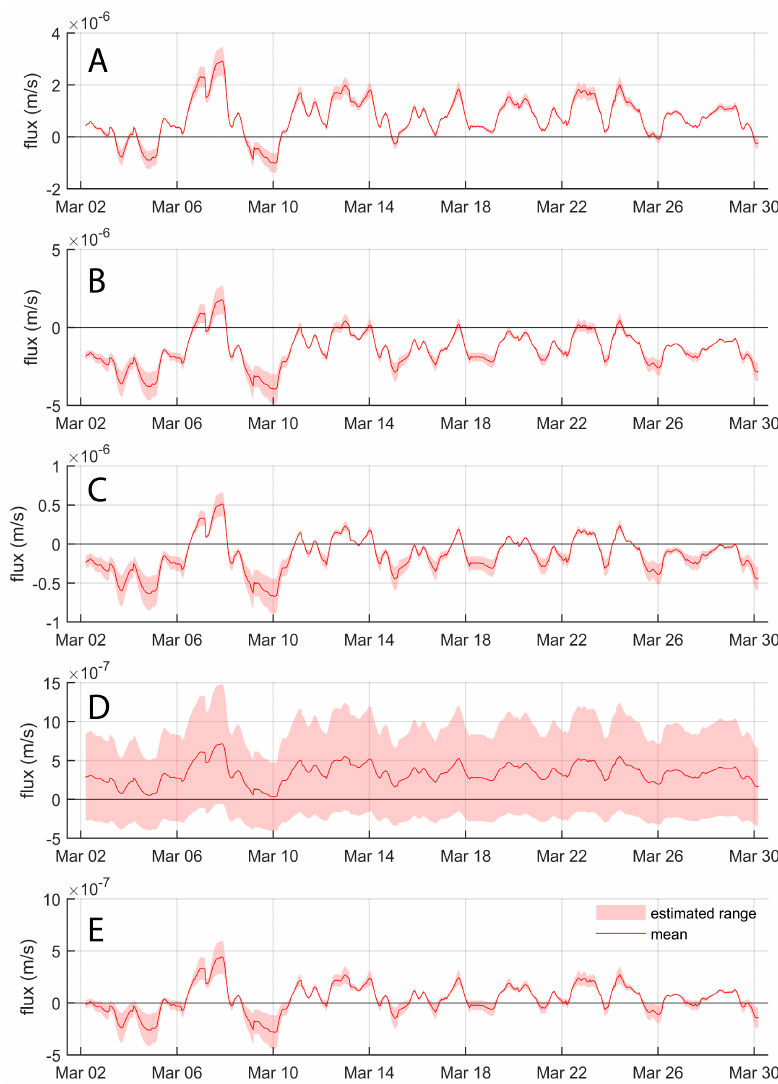
Figure 11. Time series of estimated fluxes during the monitoring period. Figure 11. time series of estimated fluxes during the monitoring period. Figure 11. time series of estimated fluxes during the monitoring period.